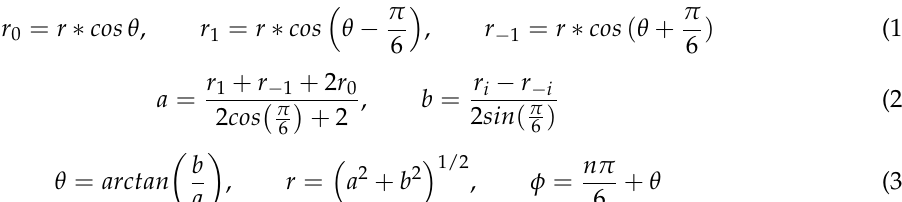
Figure 6. IR communication module’s architecture and parameters, process sequence for relative- location